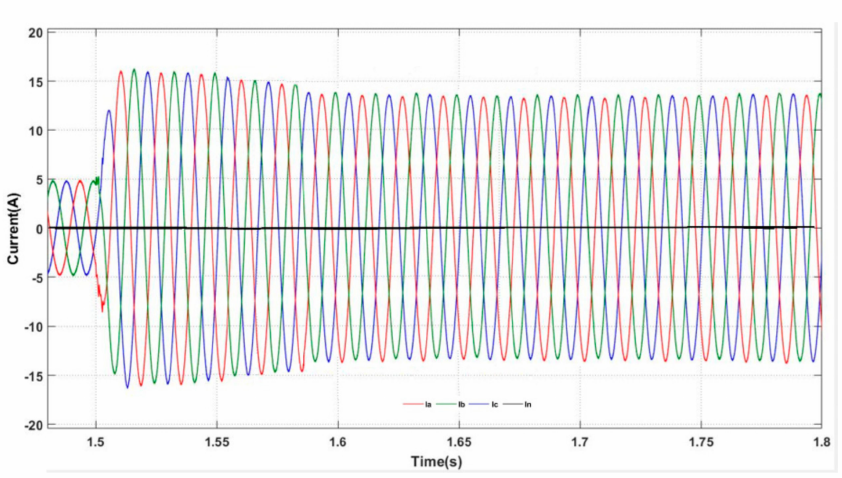
Figure 26. Experimental result of the FNN for case 4.